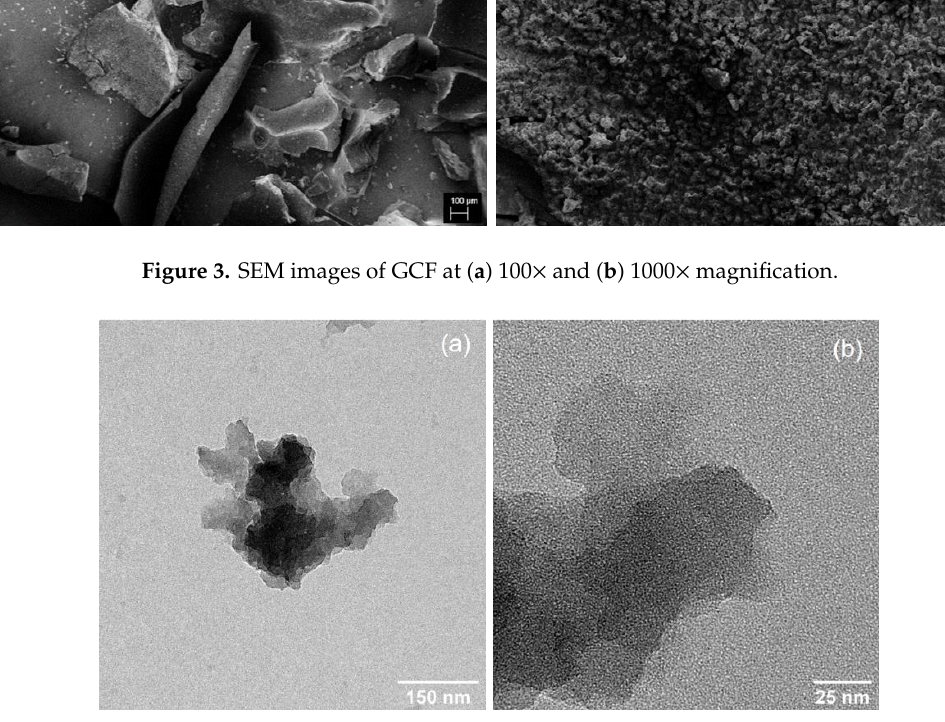
Figure 4. TEM images showing ( a ) a cluster of GCF composed of ( b ) aggregated 2D nanoplatelets.